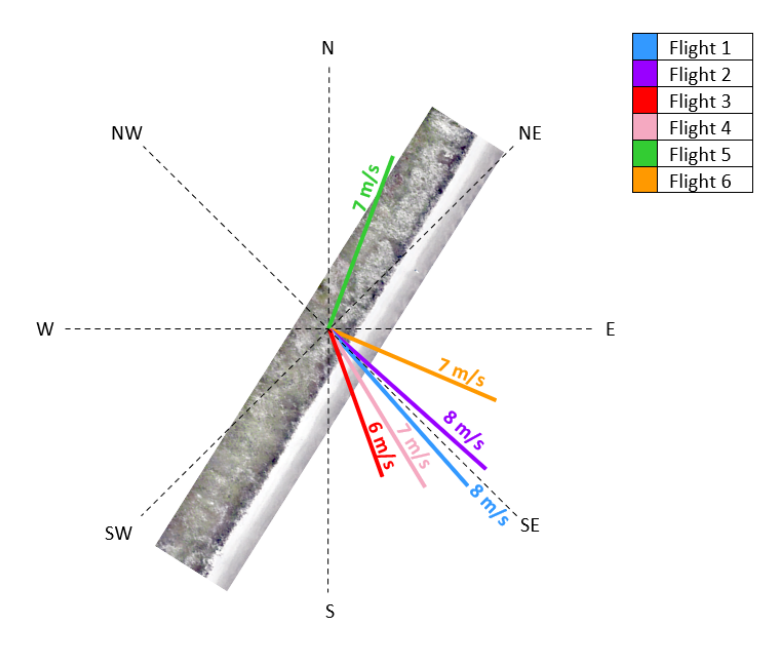
Figure 5. Wind Direction and Speed (Data Source: NOAA [43]).